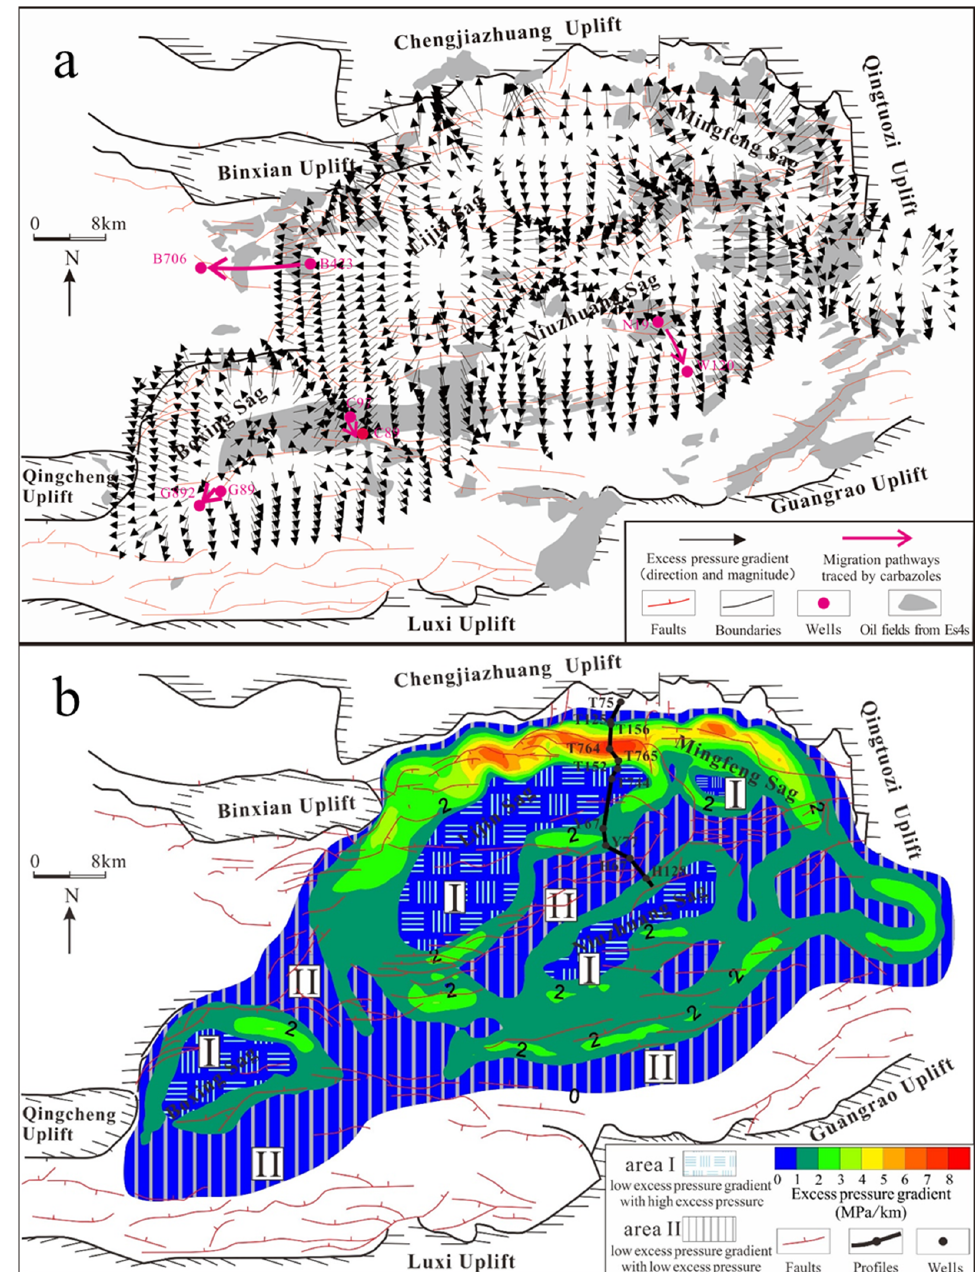
Figure 9. Distribution characteristics of plane excess pressure gradient in the upper interval of Es4 member of Dongying Depression. (( a ): in the form of arrow; ( b ): in the form of isoline).